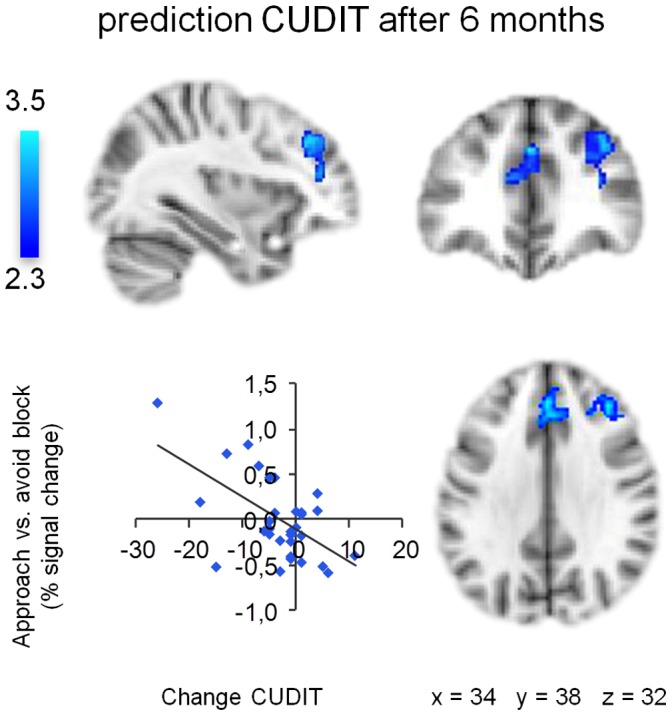
Association approach-bias activation patterns and change in cannabis problem severity.Approach-bias activation patterns in right dorsolateral prefrontal cortex and anterior cingulate cortex are negatively associated with changes in cannabis problem severity (CUDIT-scores) among heavy cannabis users at six-month follow-up. Scatter plot shows association change in CUDIT-scores and average percent signal change extracted from significant clusters. Clusters of significant activation (Z >2.3, whole-brain cluster-corrected at p<0.05) are overlaid on a standard MNI brain. Right side of the brain is depicted at right side.